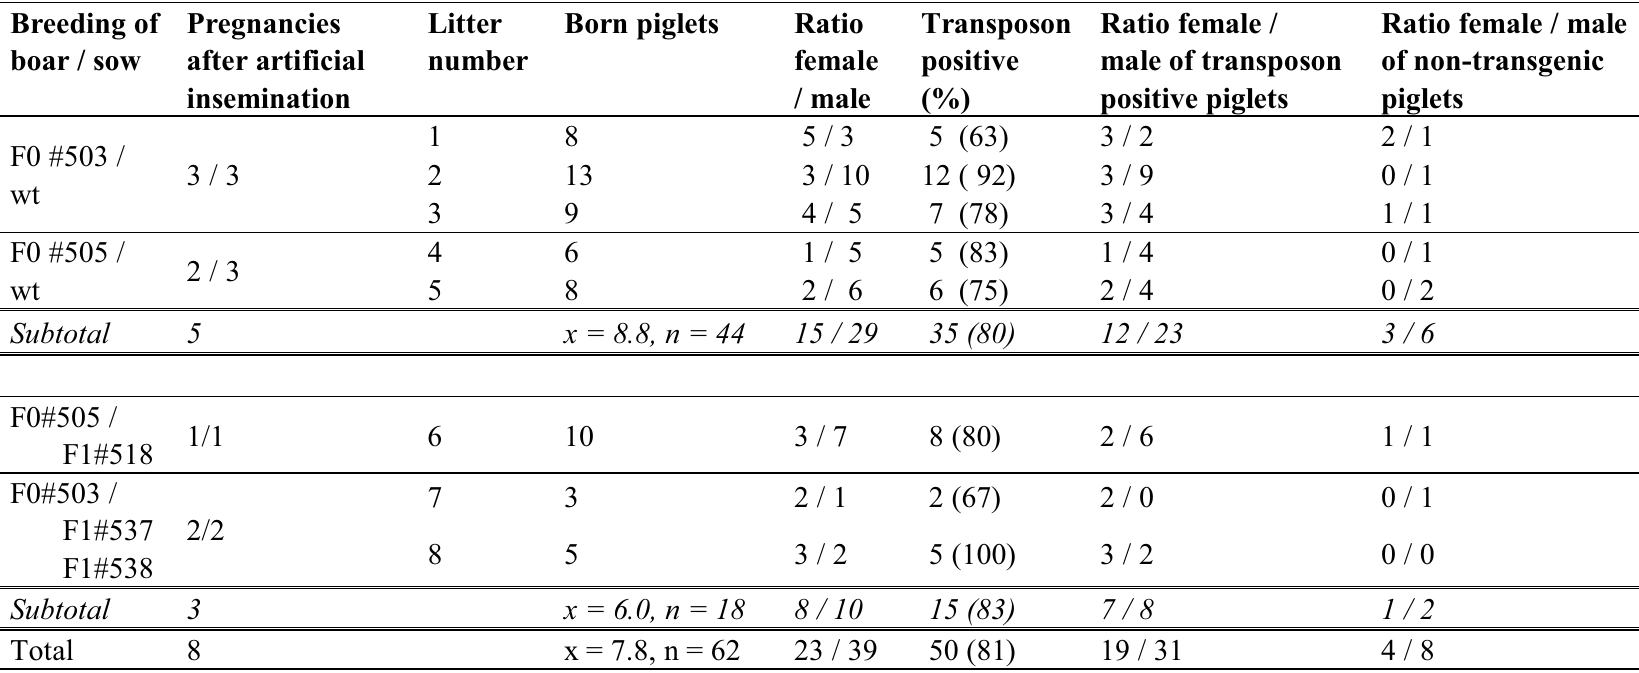
Table 1. Germ line transmission of transposon transgenic pigs and sex ratio of the